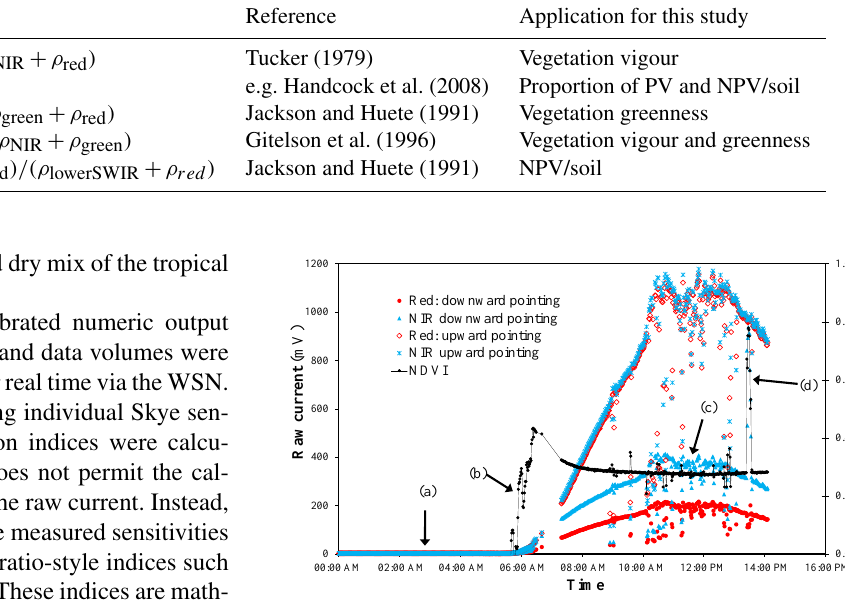
Figure 2. Example of the diurnal cycle of sensor data during the dry season when a large green leaf was held up to the multispectral sensors on the fenced node to test its response (4 October 2011). Note that for the NDVI (a) night-time values, (b) the ramp-up after dawn (approx. 06:30), (c) the relatively stable value for the middle part of the day, (d) the spike in NDVI when the sensors recorded an elevation of NIR reflectance in response to green vegetation being held up to the